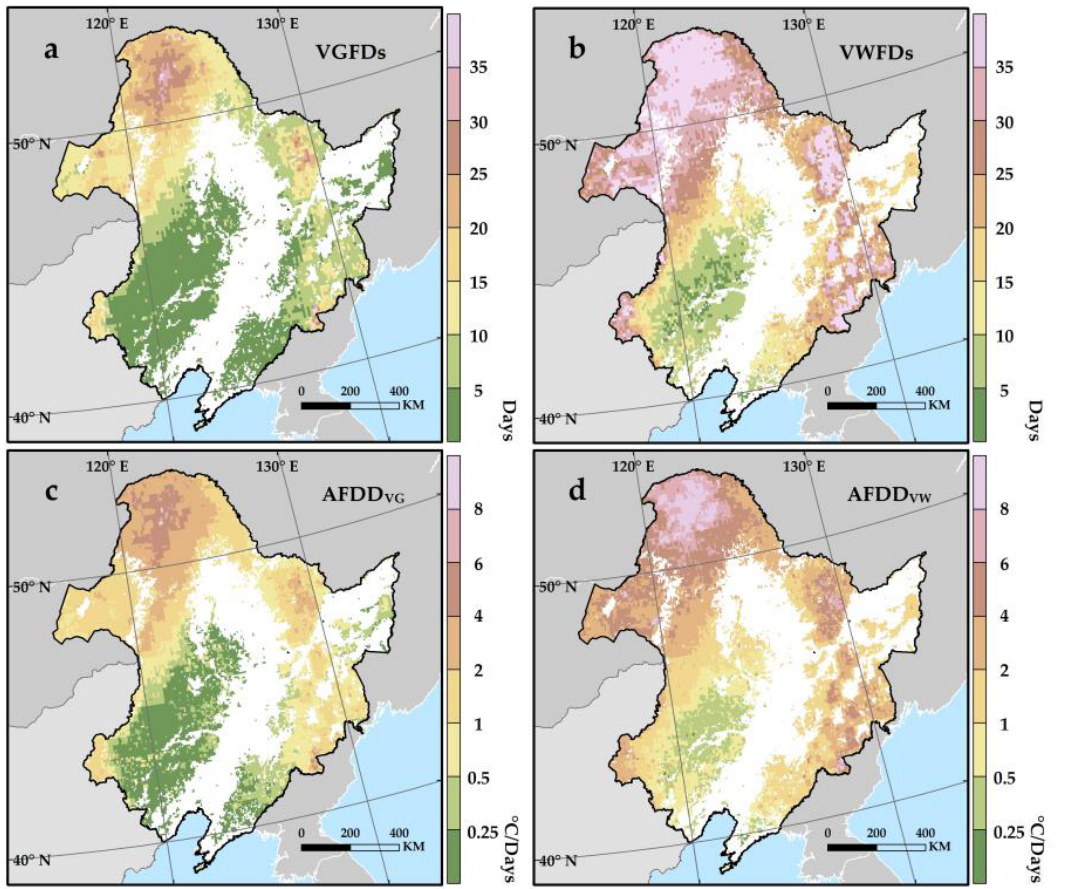
Figure 3. Spatial distribution of average values of ( a ) frost days during vegetation greenup (VGFDs); ( b ) frost days during vegetation withering (VWFDs); ( c ) average accumulated frost degree days during vegetation greenup (AFDD VG ); and ( d ) average accumulated frost degree days during vegetation withering (AFDD VW ).